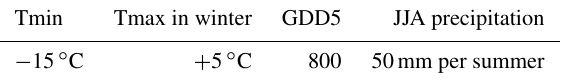
Table 1. Limiting factors for temperate deciduous tree growth used in this study. Tmin: minimum temperature of the coldest month, Tmax: maximum temperature of the coldest month, GDD5: grow- ing degree days for which the excess over 5 ◦ C is accumulated for each day, JJA precipitation: accumulated summer precipitation.